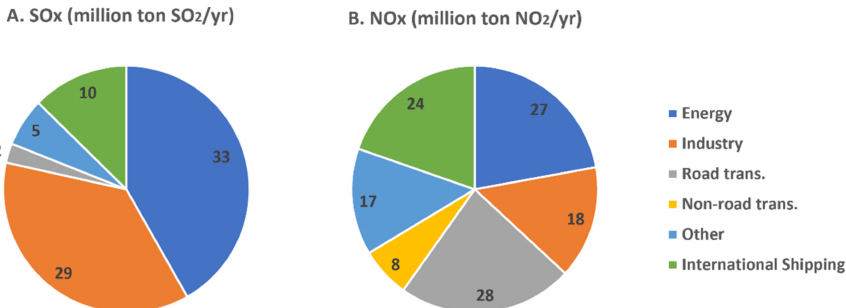
Figure 1. Global annual anthropogenic air pollution emissions by sector for 2017. ( A ) SOx emissions (in million-ton SO 2 /year). ( B ) NOx emissions (in million-ton NO 2 /year)